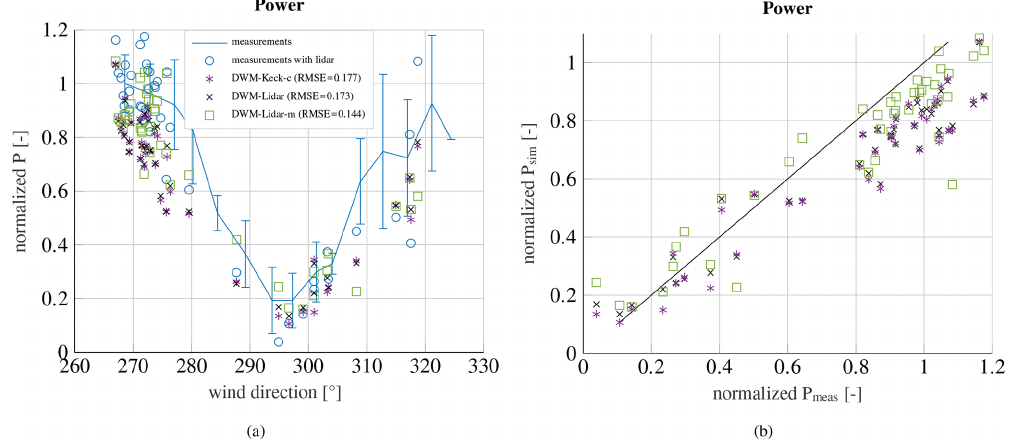
Figure 14. Measured and simulated power over the wind direction (a) and simulated power over measured power (b) at an ambient wind speed of 8ms − 1 and an ambient turbulence intensity of 10%, when WTG 2 is exposed to the wake of WTG